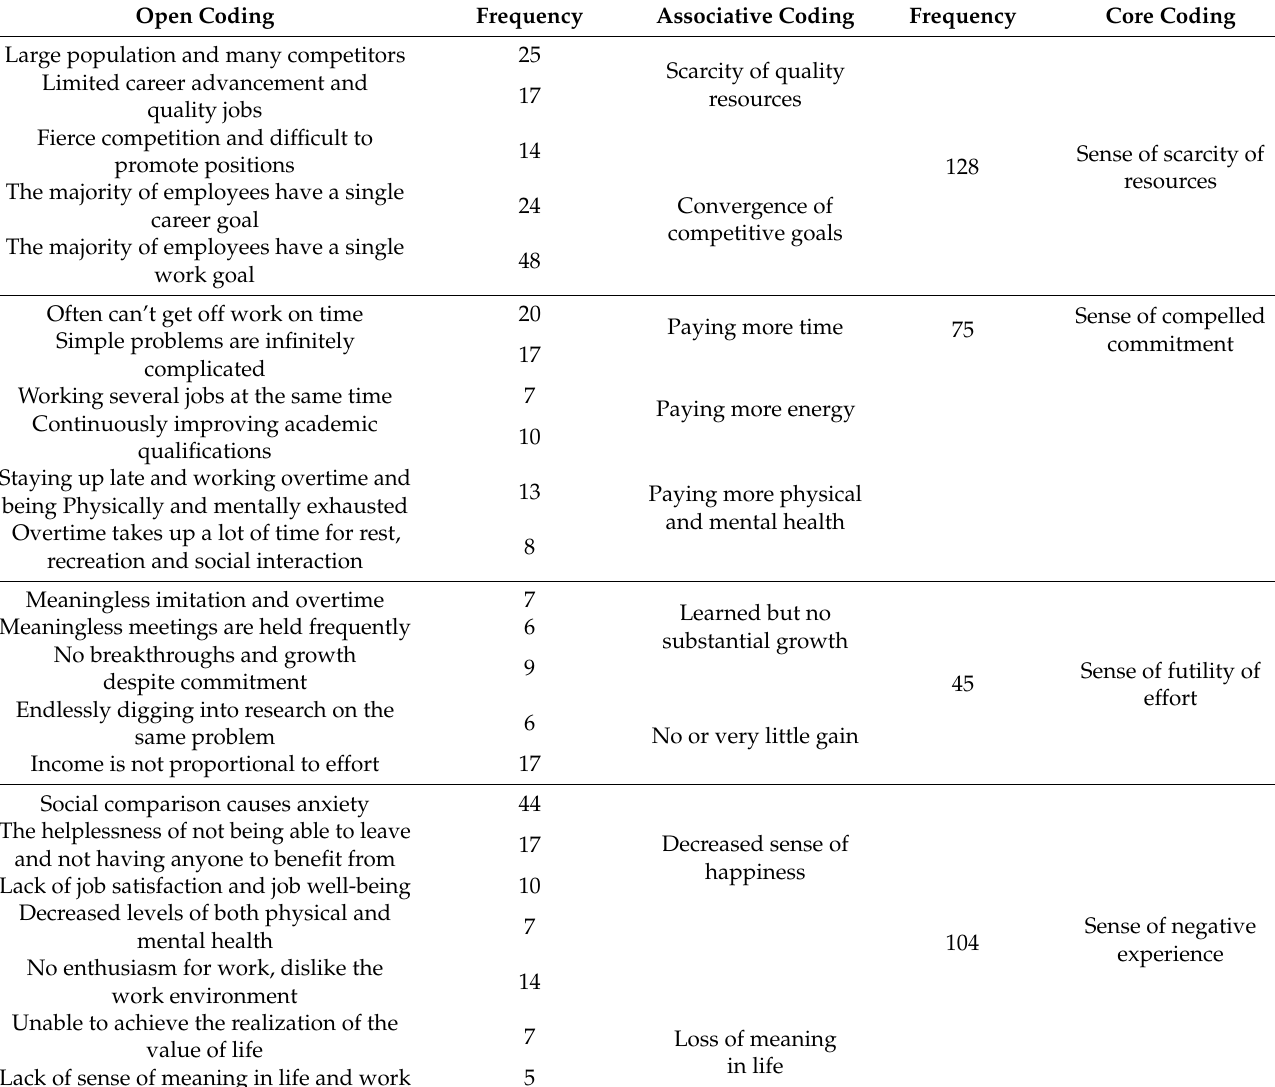
Table 1. Coding of the connotation of the sense of workplace involution for newly recruited employees. Open Coding Frequency Associative